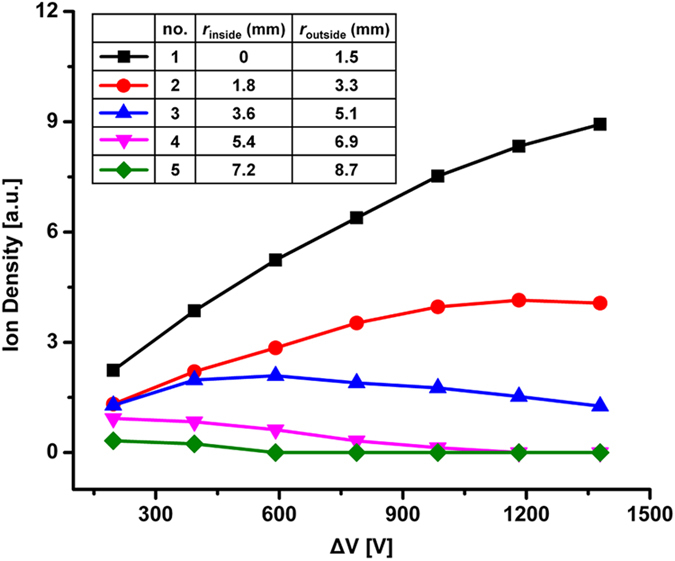
Densities of reactant ion at five different concentric detectors with the increase of ΔV from 197 to 1379 V. Inside radius of the detector: rinside, outside radius of the detector: routside.